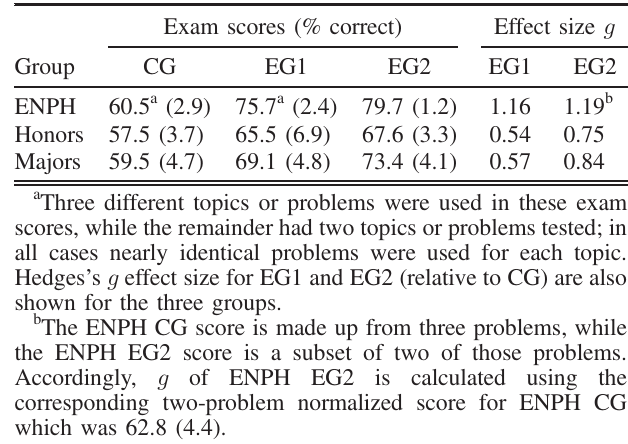
TABLE IV. Normalized scores on test problems of the control group (lecture-based) and experiment groups (transformed) for the three types of students. Standard error is shown in